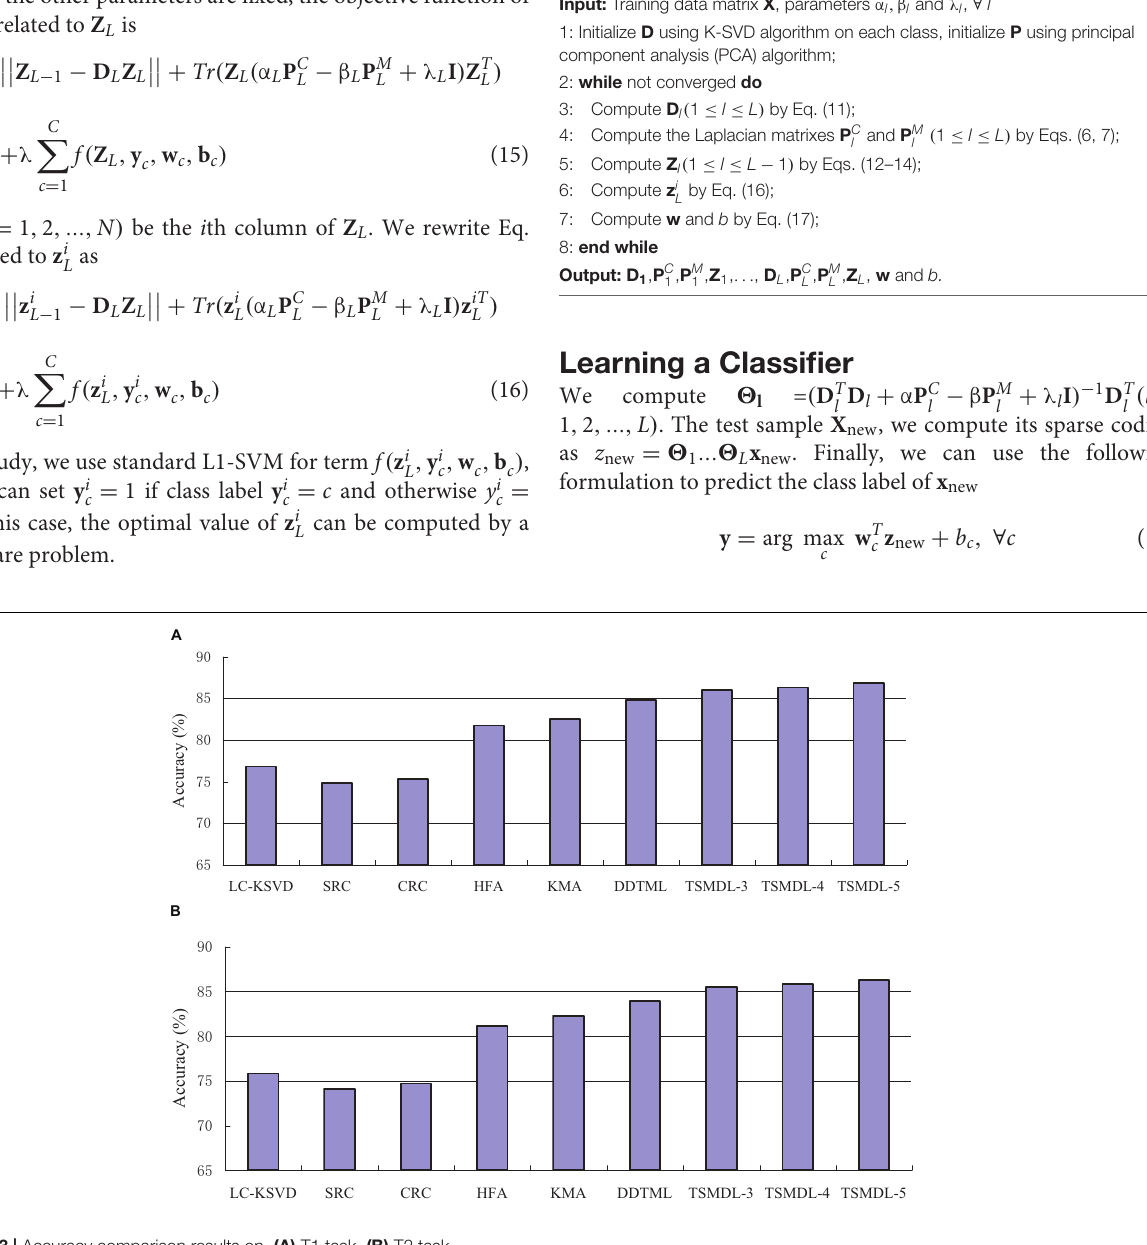
FIGURE 3 | Accuracy comparison results on, (A) T1 task, (B) T2